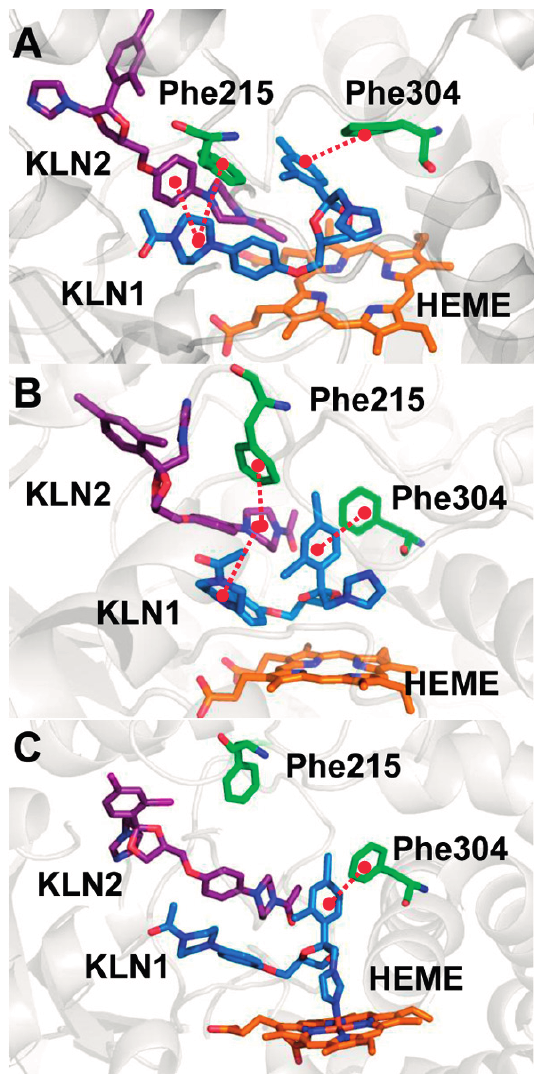
Figure 5. Pi-pi stacking interactions between Phe215, Phe304 and KLNs in the cooperative binding model of ( A ) the CYP3A4t structure; ( B ) the CYP3A4w structure; and ( C ) the crystal structure